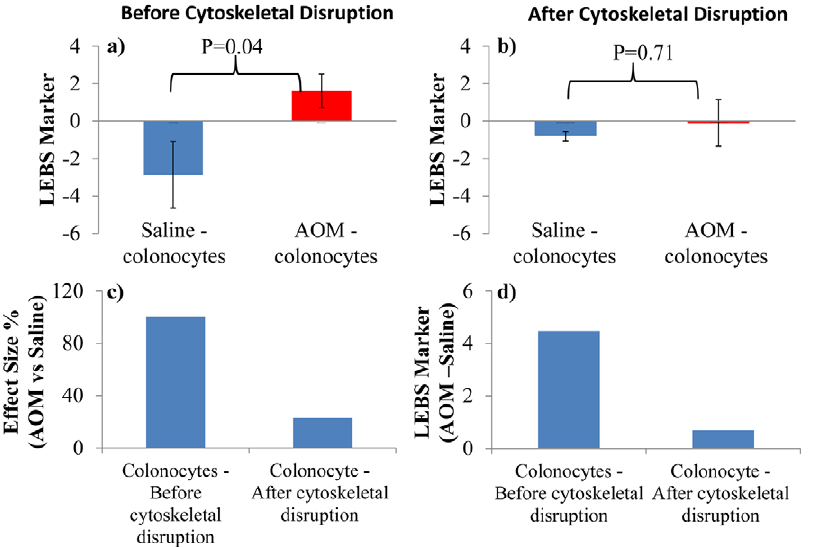
Fig. 4. Structural Changes from colon cells are primarily from aberrant cytoskeleton. a,b) The graphs show the difference in LEBS markers for colonocytes from Saline-treated and AOM-treated rats, before and after cytoskeletal disruption. AOM treatment significantly altered (p , 0.05) the LEBS marker compared to saline-treated controls. Disruption of the cytoskeletal assembly with colchicine nullified this difference (p=0.71) c,d) The effect size and delta between LEBS markers from saline-treated and AOM-treated rat colonocytes are higher before cytoskeletal disruption. The difference in structure measured by the LEBS marker between saline-treated and AOM-treated rat colonocytes was negated by disruption of the cytoskeleton, suggesting that the cytoskeleton plays a role in determining or signaling intracellular changes in early